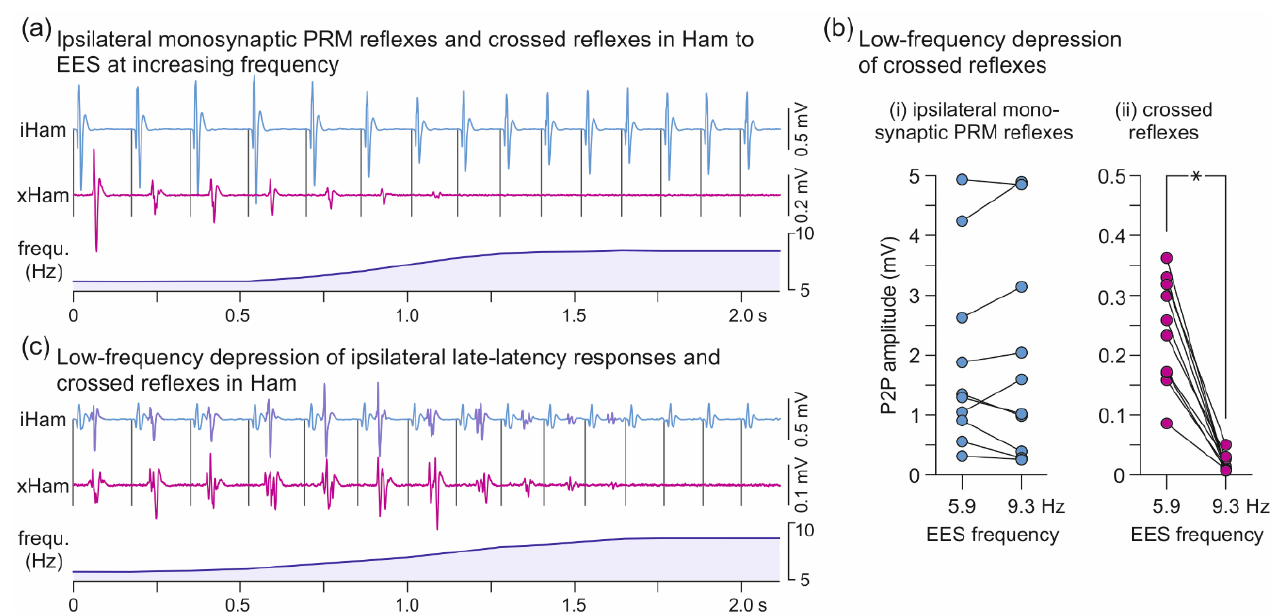
Figure 4. Low ‐ frequency depression of ipsilateral Ham reflexes and crossed reflexes. ( a ) EMG recordings of ipsilateral PRM reflexes in hamstrings (iHam) and crossed reflexes (xHam) during ongoing EES, while stimulation frequency (frequ.) was increased from 5.73 Hz to 8.45 Hz; subject 4, recording 1, right ‐ sided EES, 2+3 − , 7 V. ( b ) Mean peak ‐ to ‐ peak amplitudes of iHam and xHam responses of all available datasets (n = 10; subject 4, recordings 1 − 3) evoked at a mean frequency of 5.86 ± 0.22 Hz and 9.33 ± 0.76 Hz, respectively. Fourteen to 65 responses before and after the change of frequency were analyzed per dataset. ( c ) EMG recordings of xHam as well as two separate responses in iHam, a monosynaptic PRM reflex and a late ‐ latency response (dark blue potentials), the latter occurring within the time windows of xHam and showing a similar refractory behavior; subject 4, recording 2, left ‐ sided EES, 2+3 − , 7 V. EES, epidural electrical stimulation; PRM, posterior root ‐ muscle; *, p < 0.05.